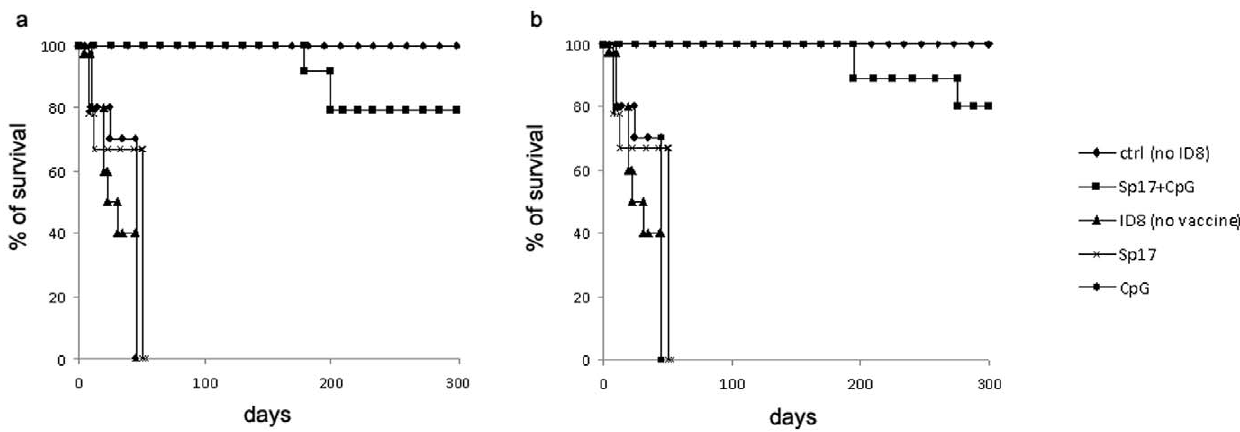
Figure 4. (a,b) Survival analysis with different vaccination schemes. Overall survival of mice from the four prophylaxis ( a ) or therapeutic ( b ) groups, detailed in the text (tumor free, Sp17 + CpG vaccinated, unvaccinated, Sp17 or CpG vaccinated). Tumor-bearing mice were i.p. injected with 10 6 ID8 cells for both the prophylactic and therapeutic regimens. Tumor cells were injected 30 days after the 3 rd vaccination of the prophylactic regimen, or 21 days before the first therapeutic vaccination. In the therapeutic group, the mean difference in weight between tumor-challenged and tumor-free animals was 10 grams at the beginning of vaccination regimen. Horizontal axis displays time expressed as days from initiation of treatment. Log-rank test indicated statistically significant difference between unvaccinated and Sp17 + CpG vaccinated versus unvaccinated or CpG treated group (p , 0.0001) for both regimens.